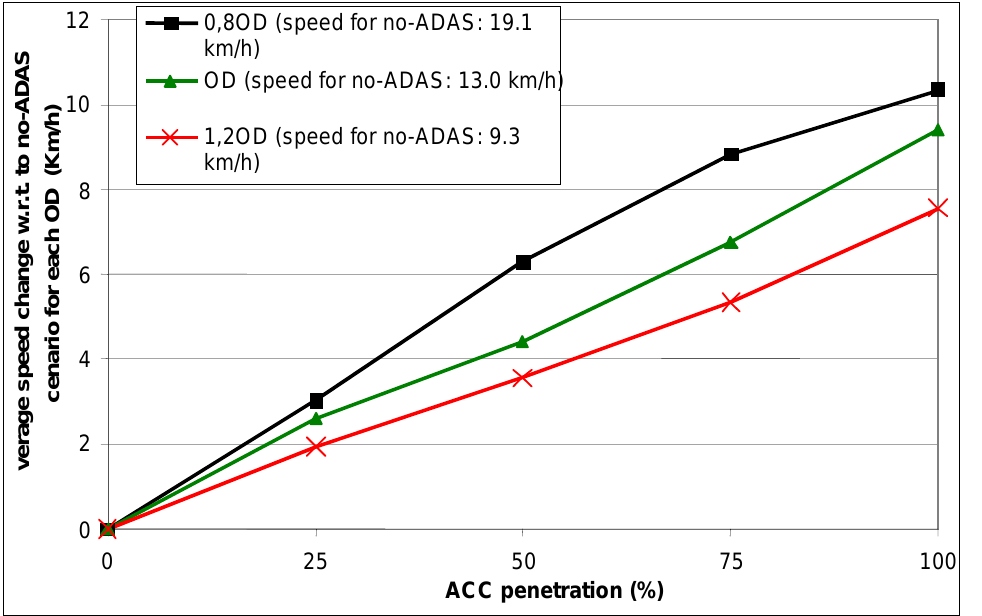
Figure 2. ACC network efficiency impact in absolute